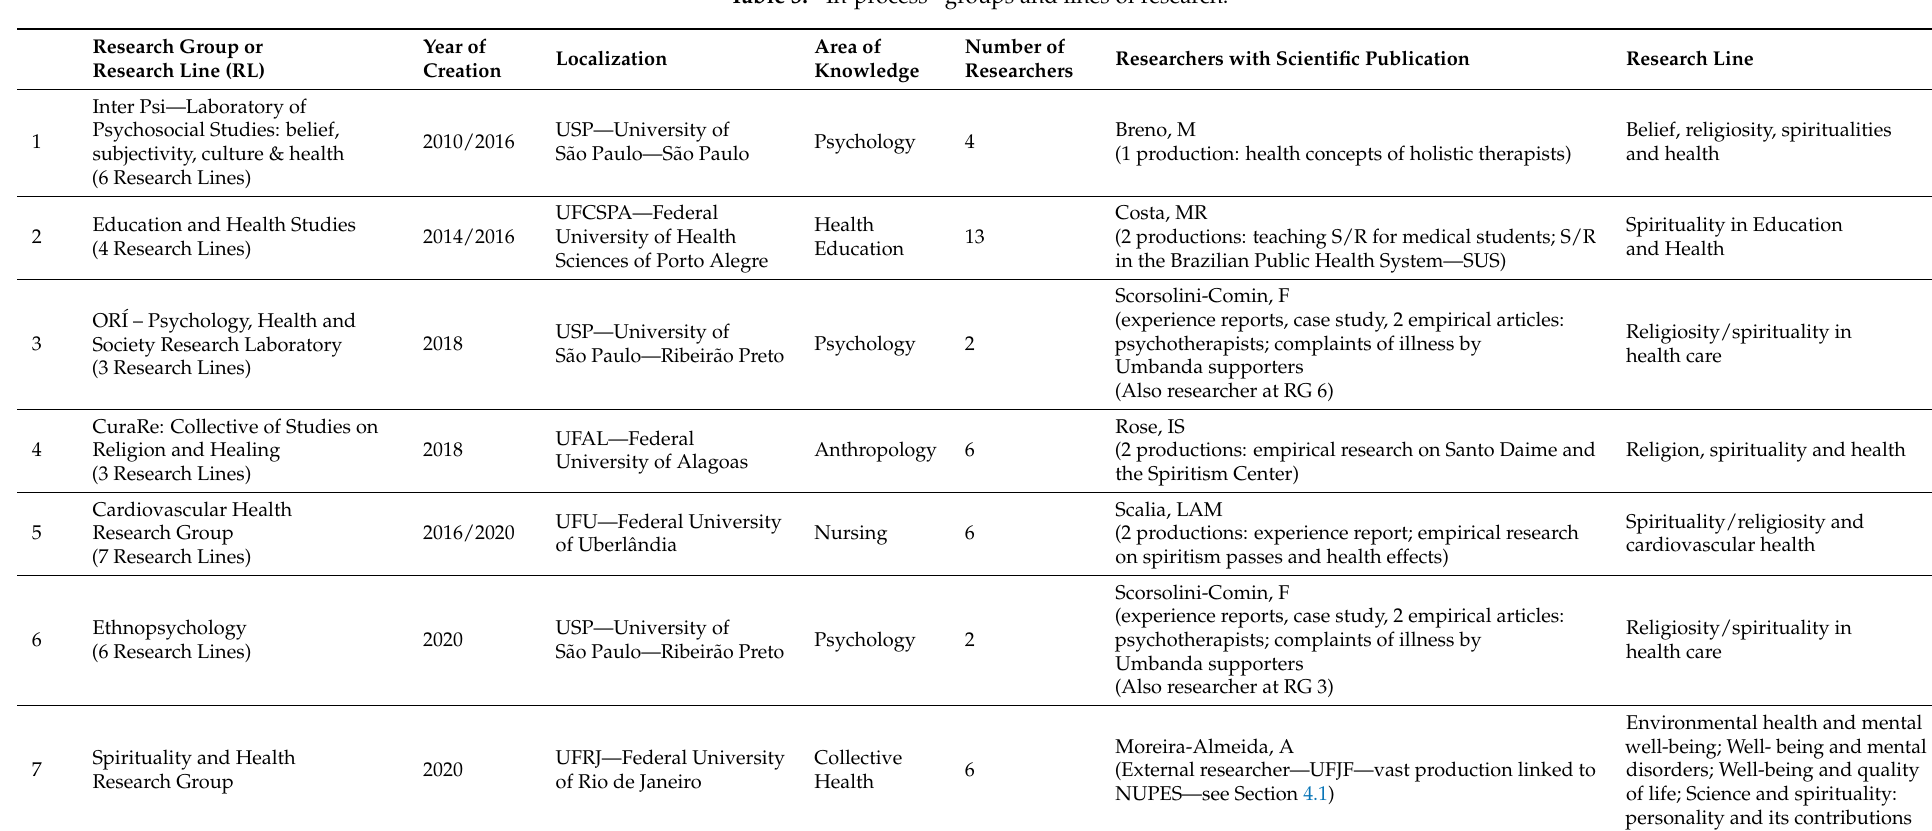
Table 3. “In-process” groups and lines of